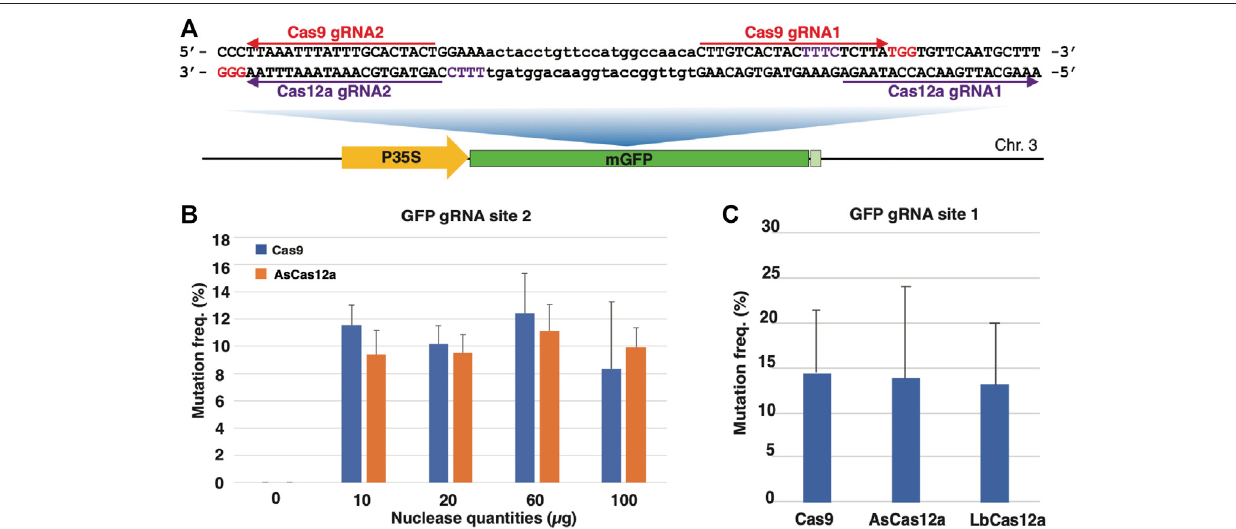
FIGURE 1 | CRISPR/Cas RNP delivery in protoplasts from N. benthamiana GFP16c line. (A) The schematic illustration of the single-copy mGFP gene and the gRNA target sites in the N. benthamiana GFP16c line. The Cas9 gRNA targeted sequences are indicated by the red arrow lines with PAM sequences highlighted in red. The Cas12a gRNA targeted sequences are indicated by the purple arrow lines with the PAM sequences highlighted in purple. The mGFP gene is located on chromosome 3 with the coding sequence represented by the green box, the CaMV 35S promoter region represented by the yellow box and the terminator region representedbythelightgreen box. (B) OptimizationoftheRNPdelivery withdifferentquantitiesoftheCas9protein.The X axis represents theCas9 RNPquantities. The Y axisindicatesthetargetedmutationfrequencies. (C) TheCas9andCas12aRNPsinduceef fi cientmutagenesisin N.benthamiana protoplasts.The X axisindicatesthe types of Cas RNPs. The Y axis indicates the targeted mutation frequencies. The error bars represent the standard deviations from 3 replicates in each RNP transfection experiment. The transfections with gRNA and nuclease alone were conducted as negative controls. No editing above sequencing background noise was found in the negative controls.